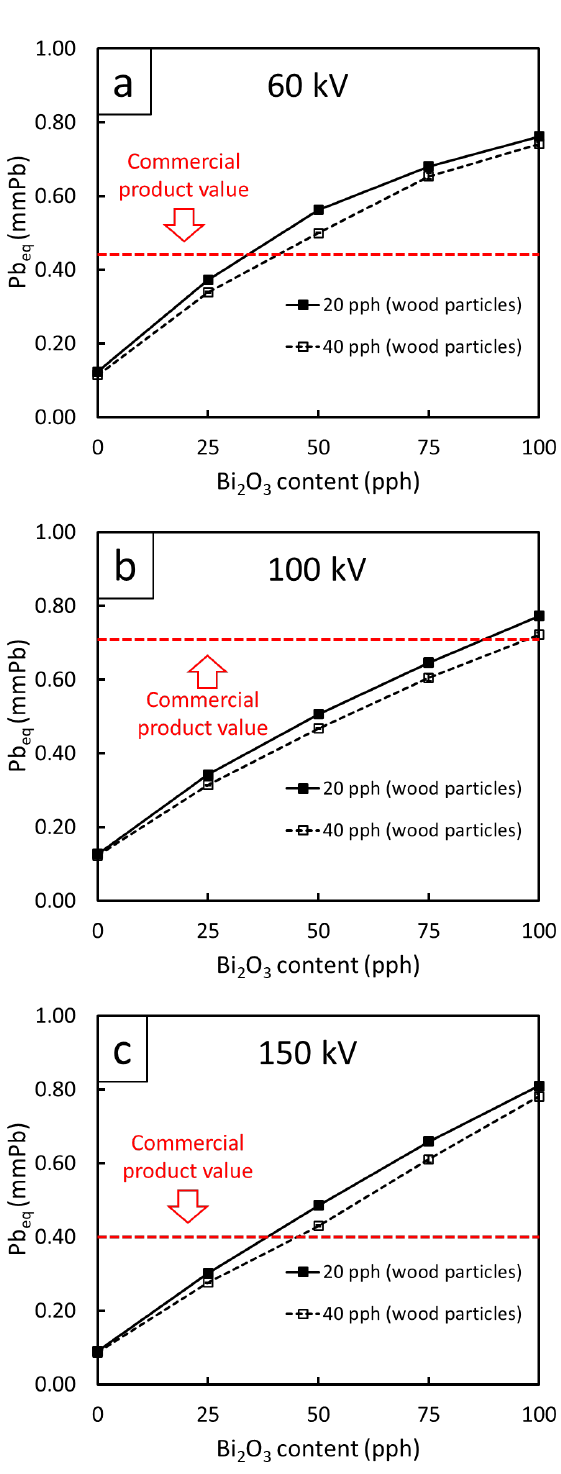
Figure 7. Lead equivalent thickness (Pb eq ) of WPVC composites containing 0–100 pph of Bi 2 O 3 and 20–40 pph of wood particles for X-rays generated from a tube with supplied voltages of ( a ) 60 kV, ( b ) 100 kV, and ( c ) 150 kV. Red dotted lines represent Pb eq values of similar commercial X-ray shielding products used for determination of recommended Bi 2 O 3 contents.